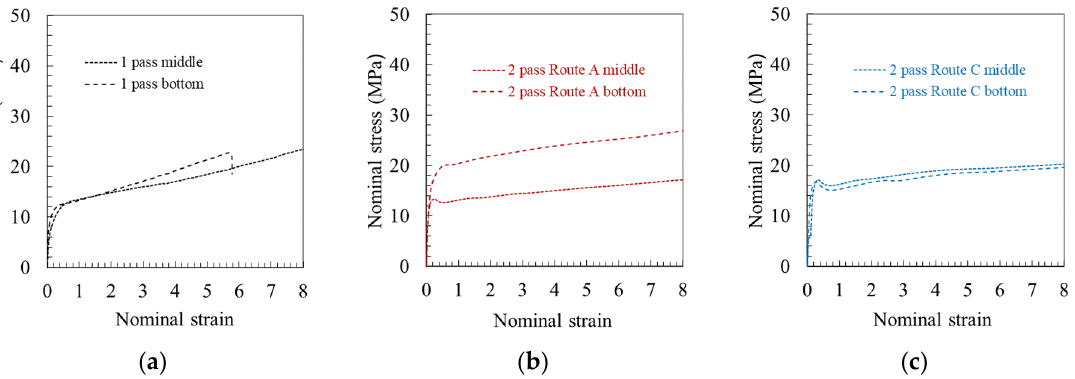
Figure 7. Tensile stress-strain curve for two specimens extracted from the middle and bottom parts of the extruded piece: ( a ) after first pass extrusion, ( b ) second pass extrusion in route A and ( c ) in route C (ram velocity of 45 mm/min and BP of 0 N).